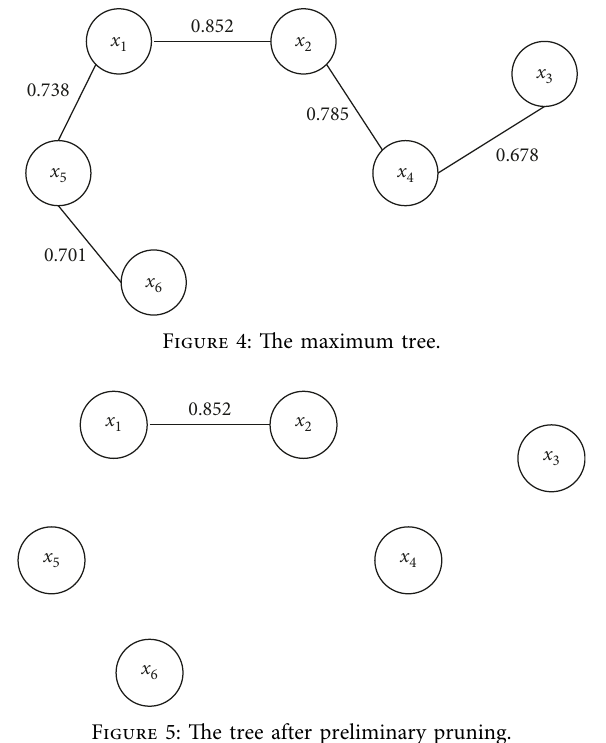
Figure 5: The tree after preliminary